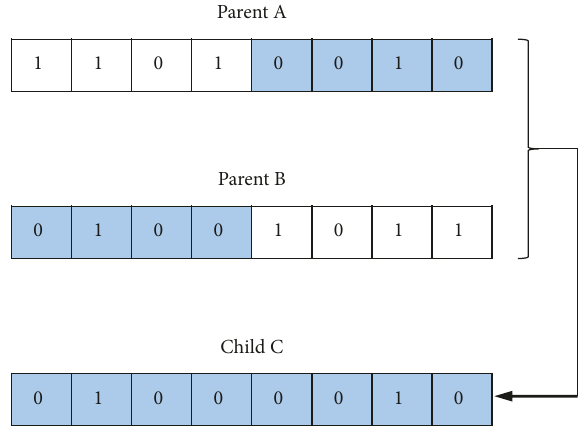
Figure 5: Schematic diagram of crossover operator